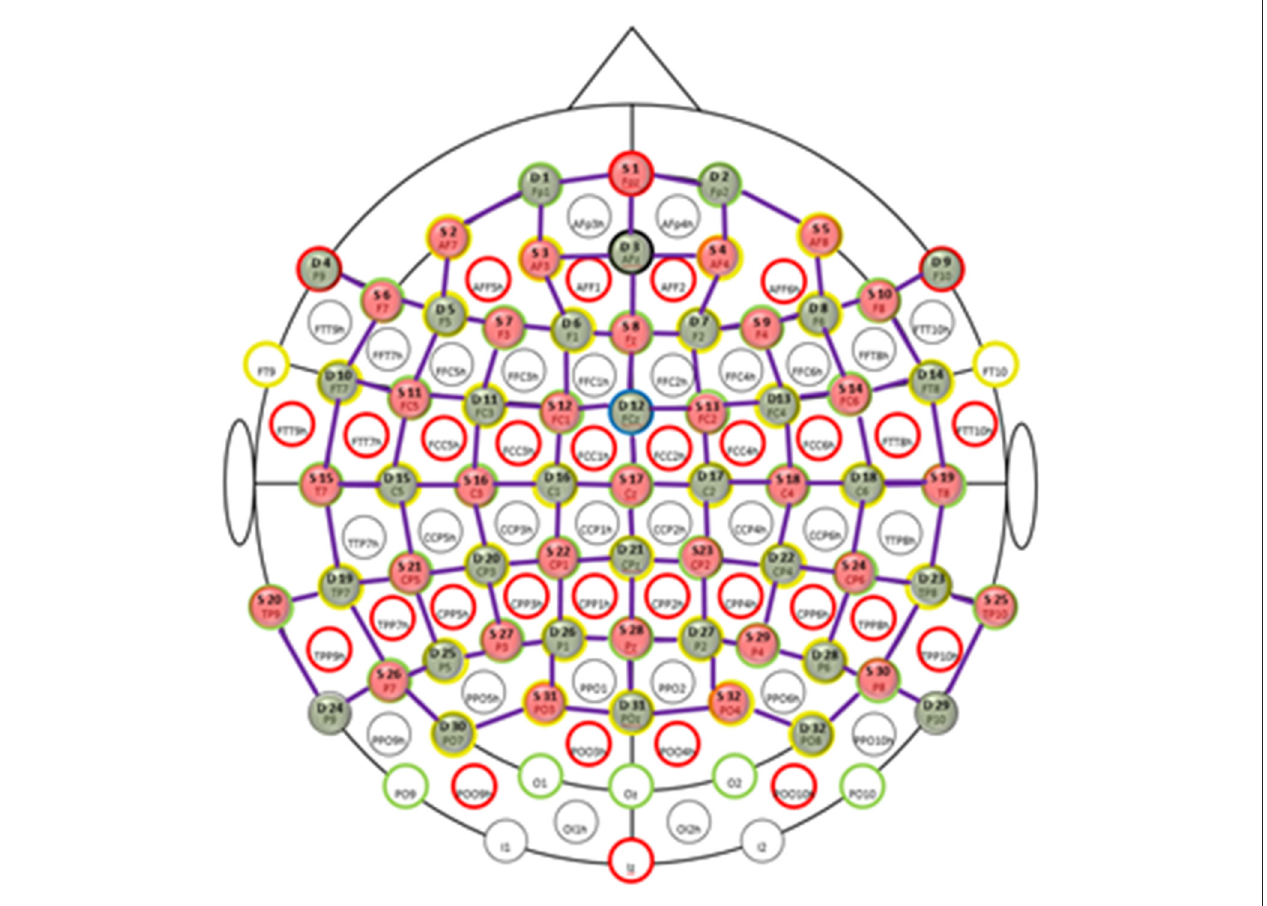
FIGURE 2 | FNIRS probe placement. Topologic layout of the emitters (red disks), detectors (green disks) and the fNIRS channels (purple lines) on a standard 10–20 EEG system. Figure reproduced from NIRStar 15.0 data acquisition software with permission from NIRx Medical Technologies,